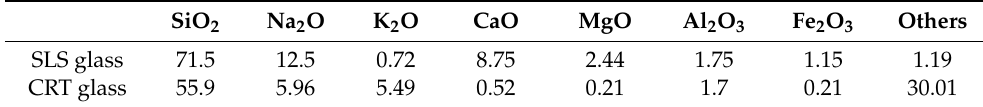
Table 2. Chemical compositions of SLS and CRT glass powder (ICP-MS analysis).